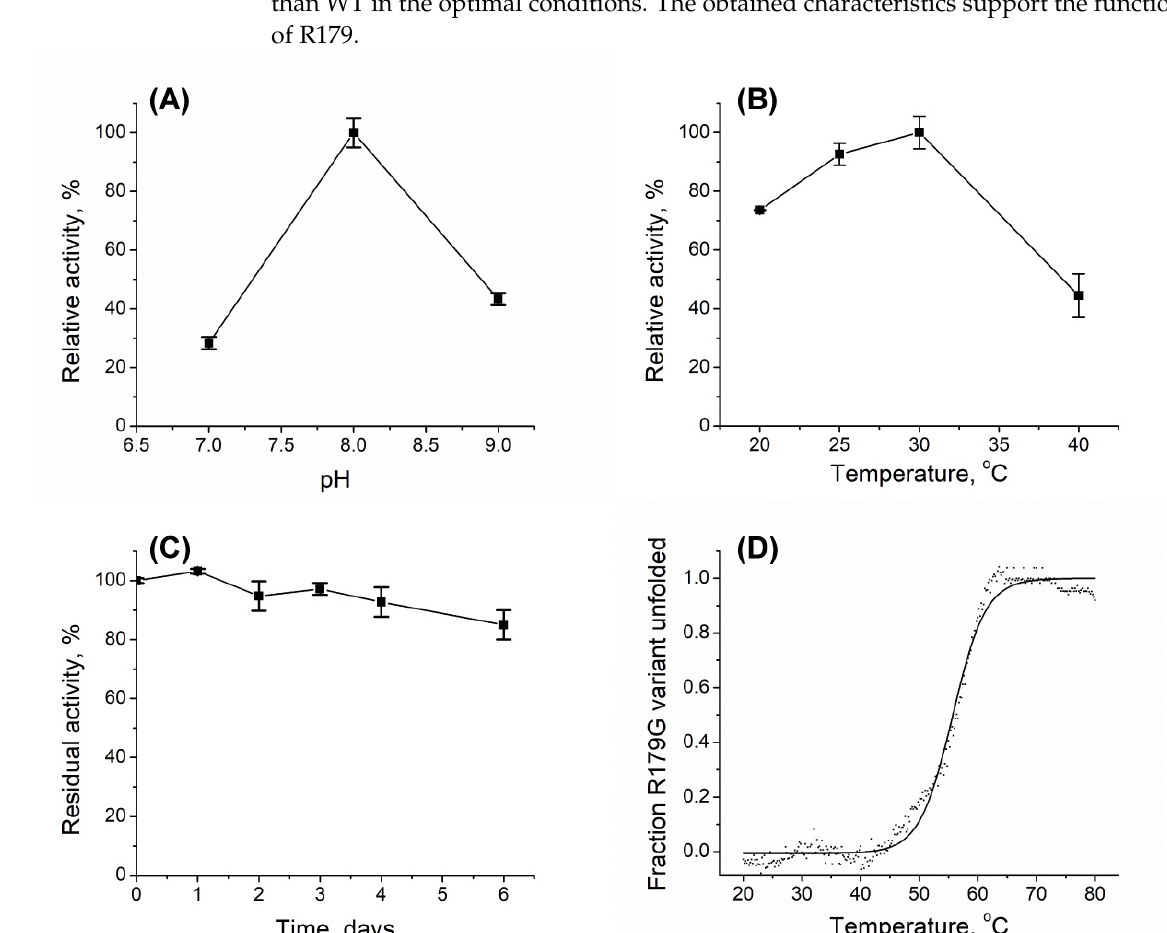
Figure 4. Kinetic and thermodynamic stability of the R179G variant. ( A , B ) The effects of pH and temperature on the overall reaction between D-alanine and α -ketoglutarate; 100% corresponds to 0.20 ± 0.01 U/mg ( A ) and 0.32 ± 0.02 U/mg ( B ). ( C ) The residual activity of the R179G variant incubating at 40 °C, 100% corresponds to 0.32 ± 0.02 U/mg in the standard assay. Error bars represent standard deviation. ( D ) Thermal unfolding in K-phosphate buffer, pH 8.0.